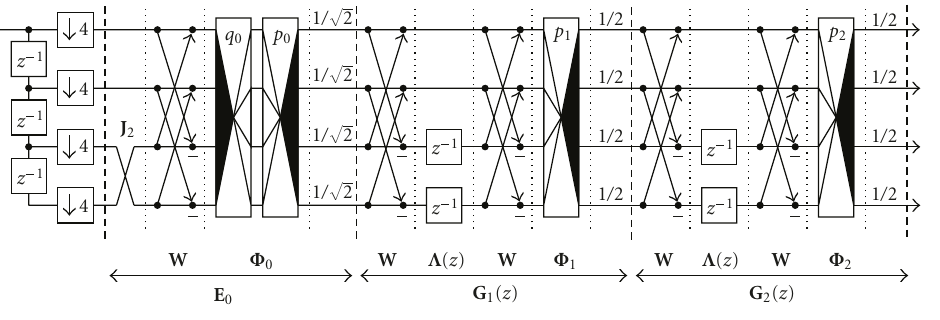
Figure 7: Quaternionic lattice structure for 4-channel LP PUFB ( N = 3).